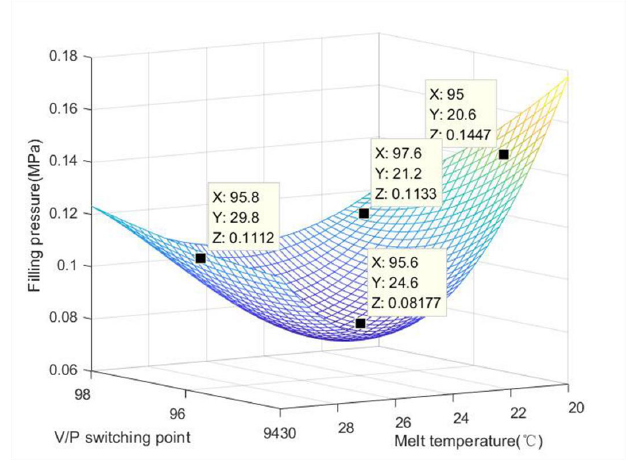
Figure 9. Effect of melt temperature and V/P switching point on the filling pressure. Table 4. Influence of pressure change at the gate. The filling pressure is a very important indicator in the injection molding process. The pressure determines the size of the injection molding process window, and the distribution